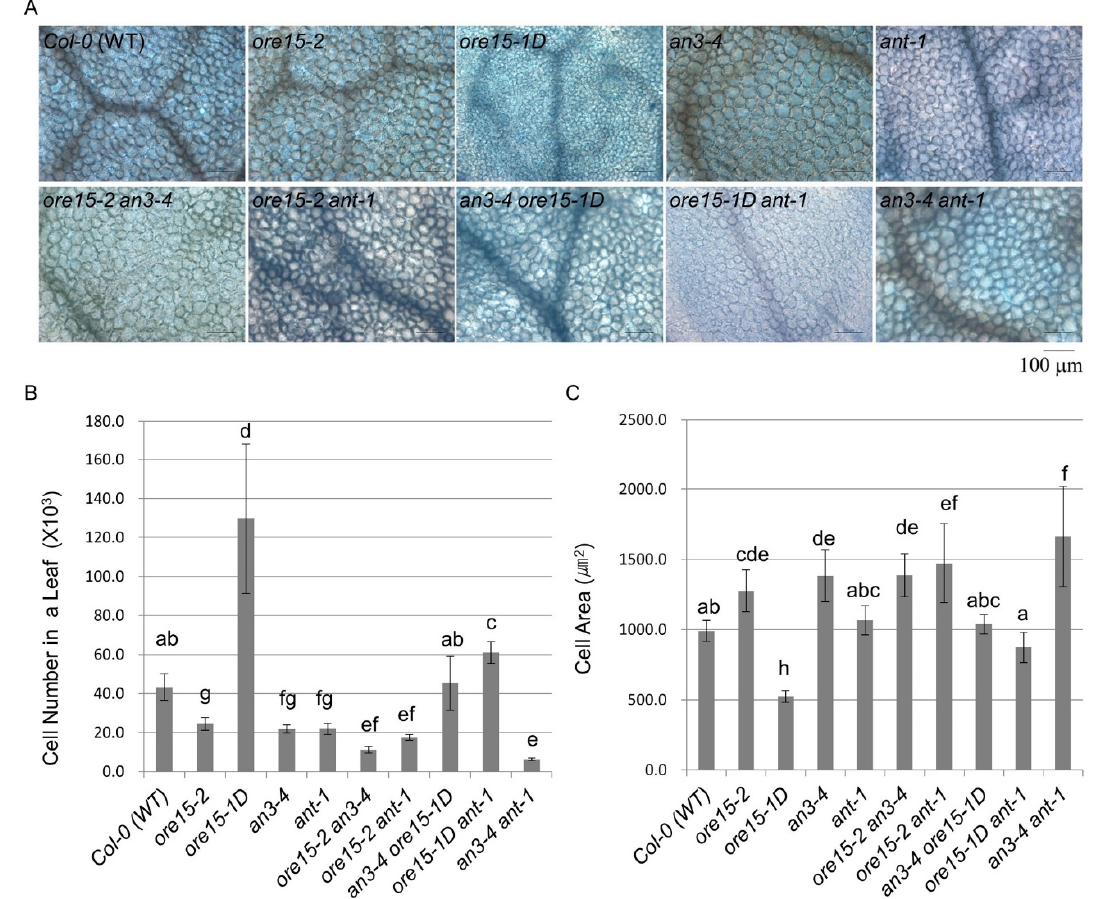
Figure 4. Statistical analysis of leaf palisade mesophyll cell number and area in mature third leaves from Col-0 (WT), single mutant, and double mutant plants at 21 DAS. ( A ) Paradermal images of palisade mesophyll cells on mature third leaves. Scale bar = 100 μm. ( B ) Cell number. ( C ) Cell area. Data are means ± SE (4 ≤ n ≤ 7). Means were compared using one-way ANOVA followed by Duncan’s multiple range test. Different lowercase letters indicate significantly different means between genotypes.